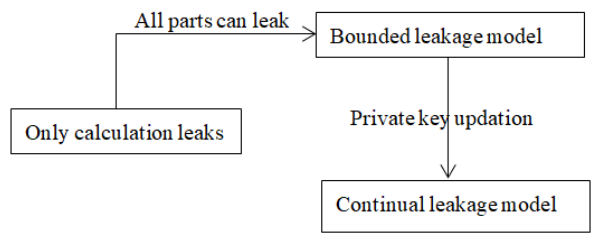
Figure 1. The relationship between the three leakage models.